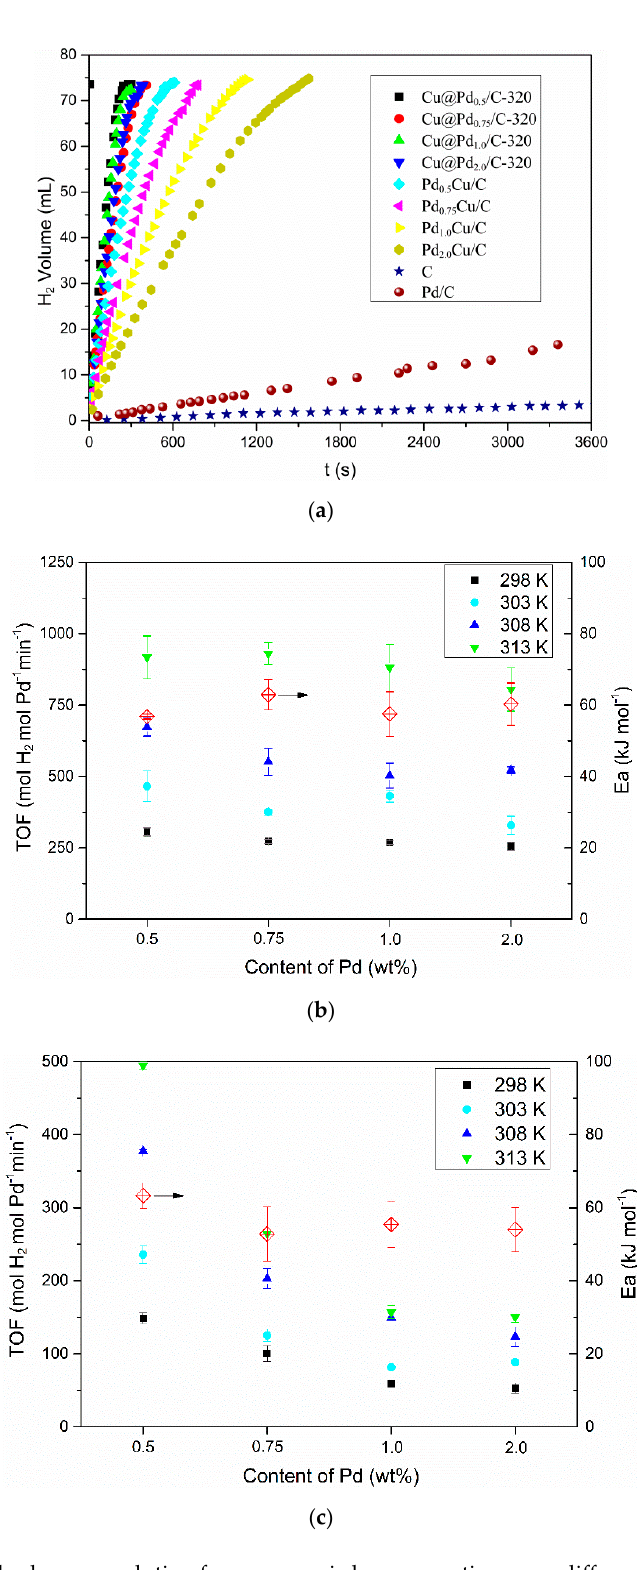
Figure 5. Plots of hydrogen evolution from ammonia borane vs. time over di ff erent catalysts at 298 K ( a ), TOFs on Cu@Pd / C-320 ( b ) and PdCu / C ( c ) at di ff erent temperatures and the corresponding